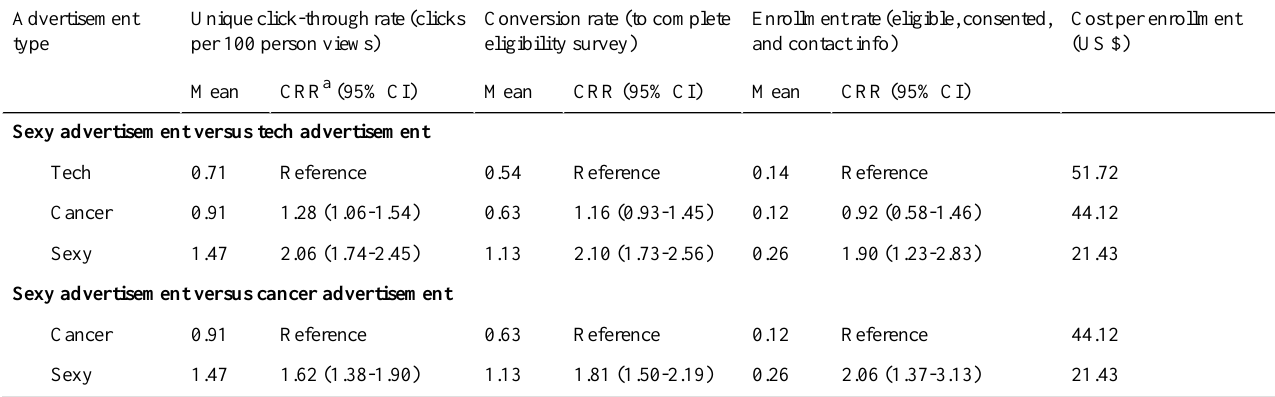
Table 1. Unique click-through, conversion, and enrollment rates are presented for each of the advertisement themes. Cost per enrollment is also reported for each advertisement theme.